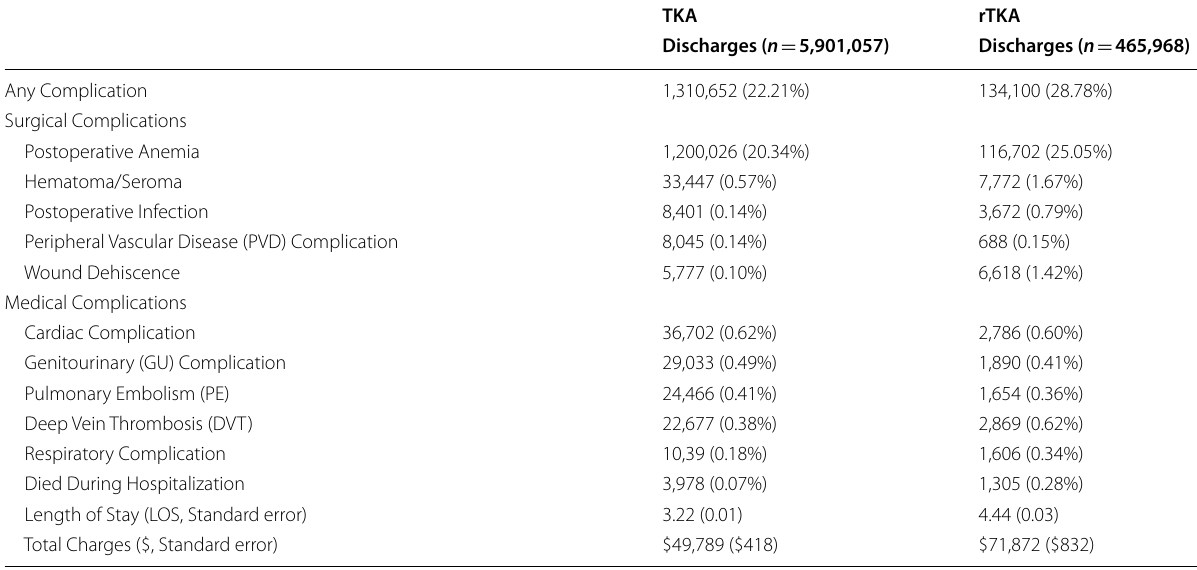
Table 3 In‑hospital outcomes collected from the NIS database of patients undergoing TKA and rTKA from 2006 to the third quarter of